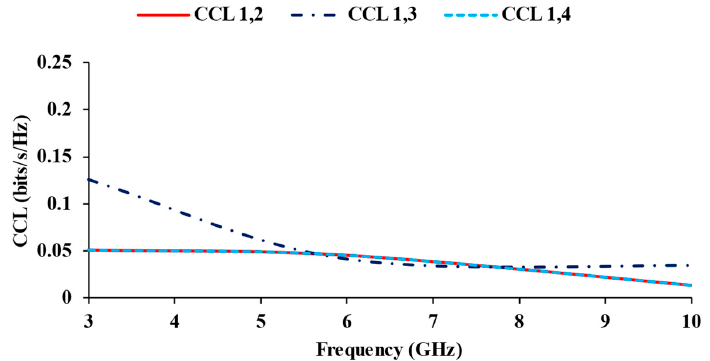
Figure 16. CCL plots of the MIMO antenna.